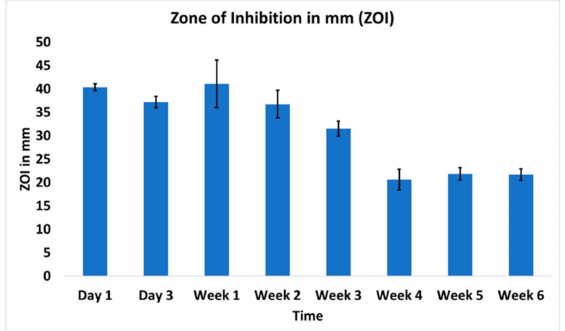
Figure 2. The zone of inhibition from the released drugs showed excellent antibacterial property against S. aureus (ATCC 49230). n = 4 for each time